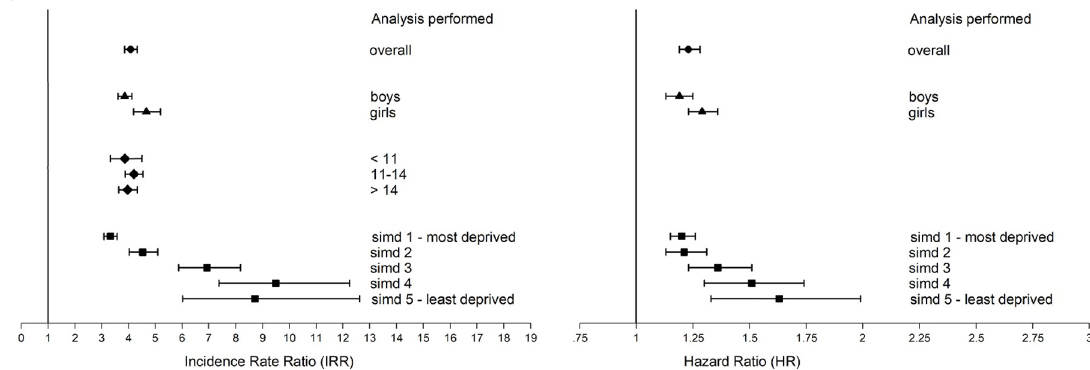
Fig 2. Forest plots of the association between being looked after at school and both school exclusion (left) and hospital admission (right) by sex, age, and deprivation. Adjusted for age, sex, deprivation quintile, ethnic group, maternal age, maternal smoking, parity, mode of delivery, gestation at delivery, sex gestation-specific birth weight centile, and 5-minute Apgar score. HR, hazard ratio; IRR, incidence rate ratio; SIMD, Scottish Index of Multiple